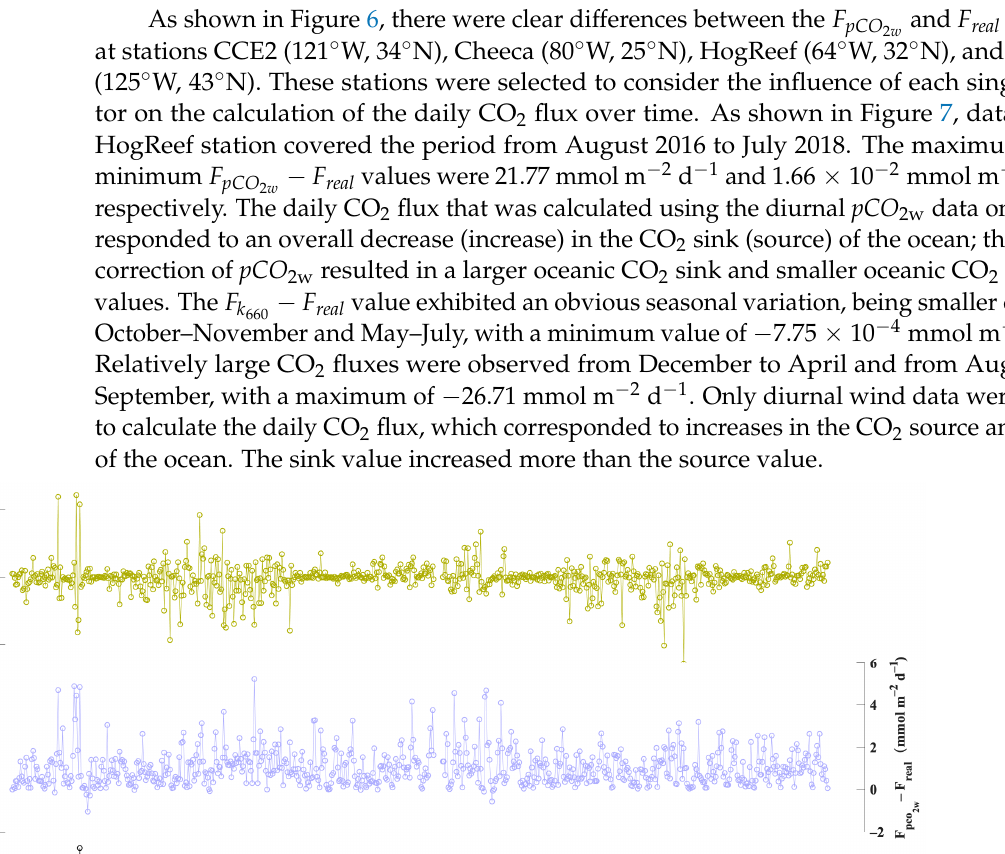
Figure 7. Differences in experimental CO 2 fluxes ( station from August 2016 to July